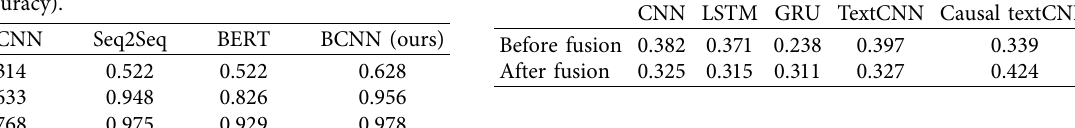
Table 4: RMSE scores of models before and after feature